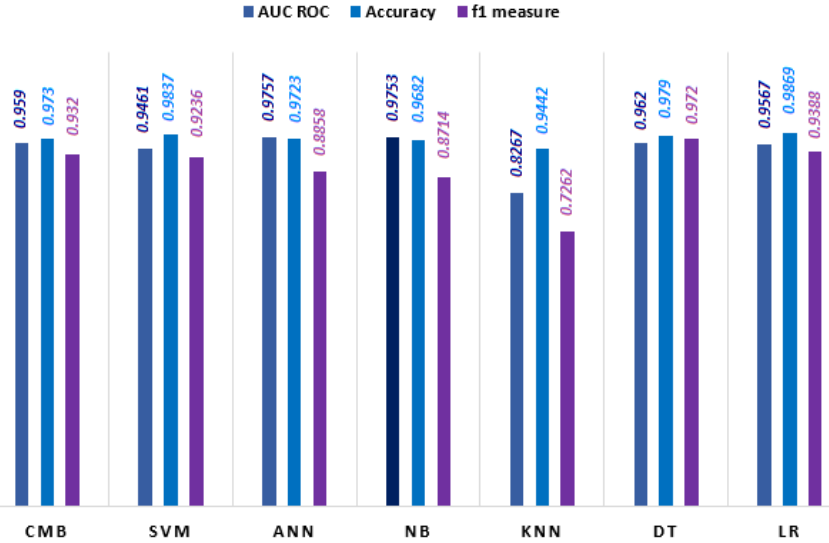
Figure 6. Comparison of CMB models’ performance with other common machine learning models.